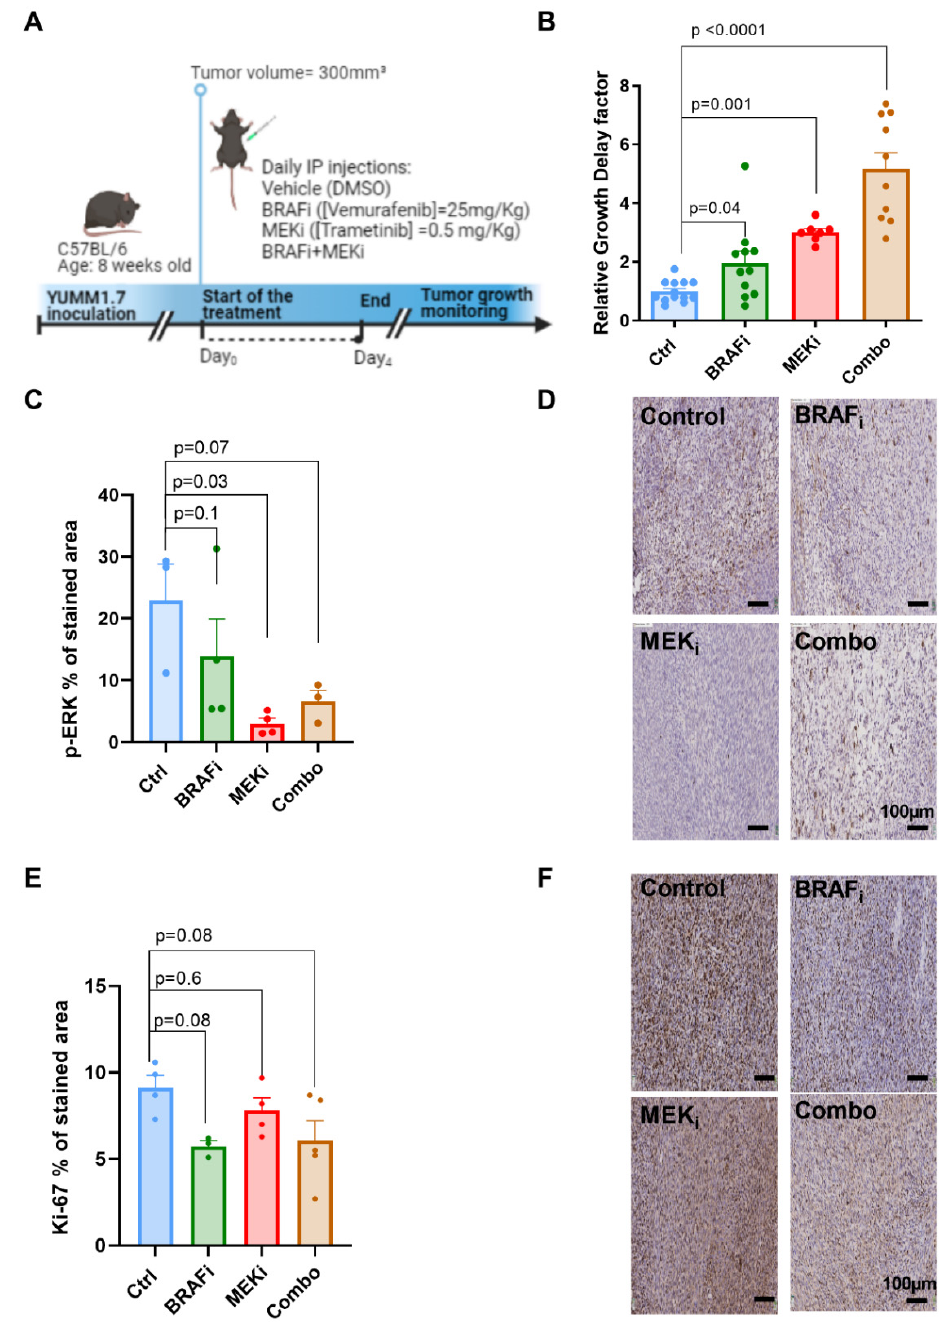
Figure 1. Growth delays, p-ERK and Ki-67 staining in YUMM1.7 melanoma xenografts. Timeline of the in vivo protocol ( A ). The tumor growth delay of melanoma xenografts was calculated as the time, in days, to reach the volume of 800 mm 3 ; sample size n = 13 for Ctrl, n = 11 for BRAF i and n = 7 for MEK i and n = 10 for Combo ( B ). p-ERK % of stained area at 4 h after treatment and Ki-67 % of stained area at 24 h after treatment. The % of stained area was calculated as the ratio between stained and tissue are multiplied by 100. ( C , D ). p-ERK and Ki-67 representative staining of melanoma xenografts collected 4 h and 24 h, respectively, after a single injection of the indicated treatments. ( D – F ) All scale bars = 100µm.